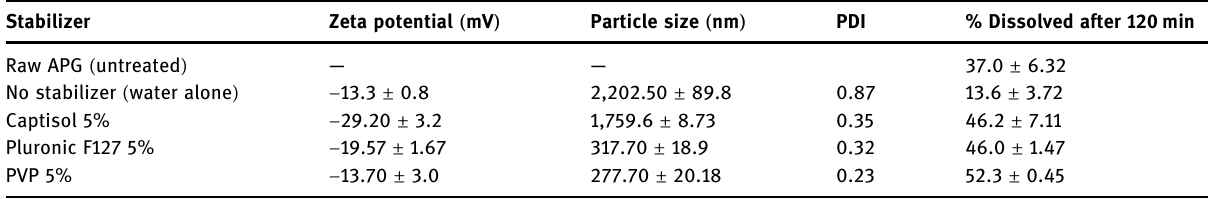
Table 3: Screening data for the e ff ect of di ff erent stabilizers on APG nanoparticles prepared by planetary ball milling by using 500 rpm as milling speed, milling ball size of 0.5 mm, solid/solvent ratio of 0.1, and 3 milling cycles ( each of 10 min with 5 min pause )